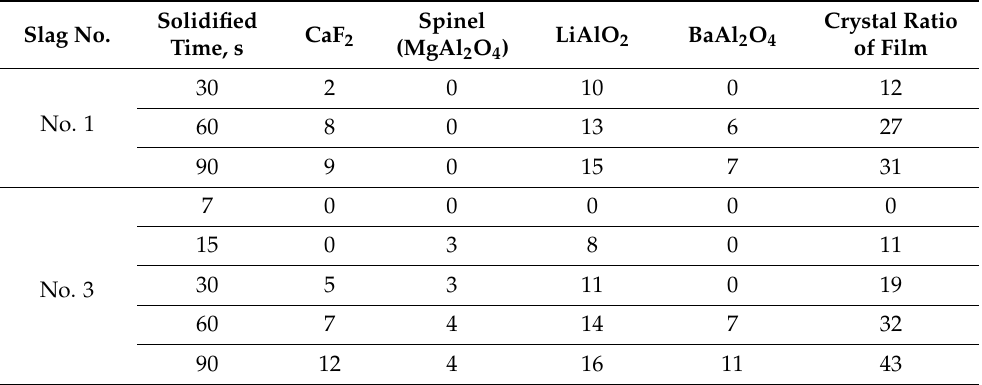
Table 4. Typical crystal ratios of films solidified at different times (%). Slag